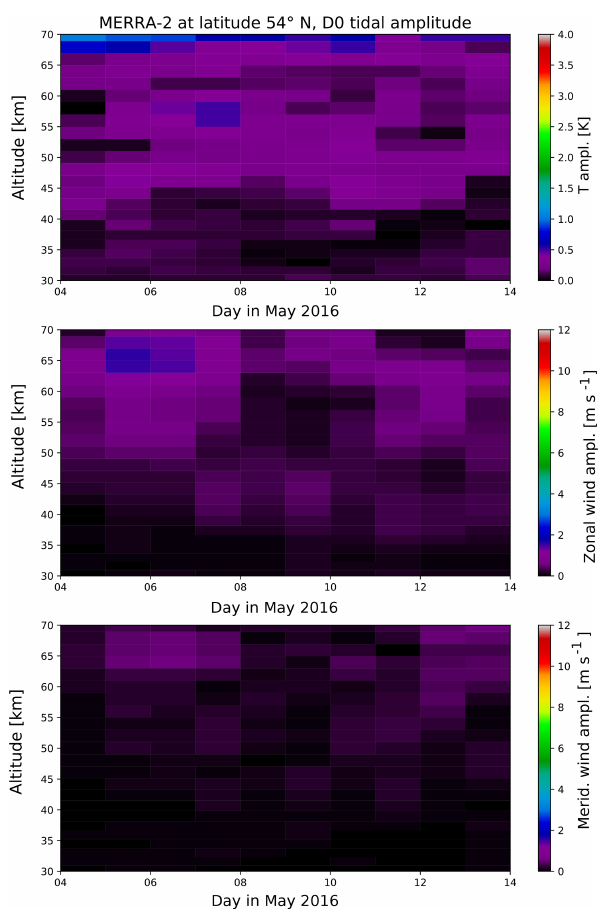
Figure A1. D0 amplitude in temperature, zonal and meridional wind from global MERRA-2 fields at the latitude of 54 ◦ N.